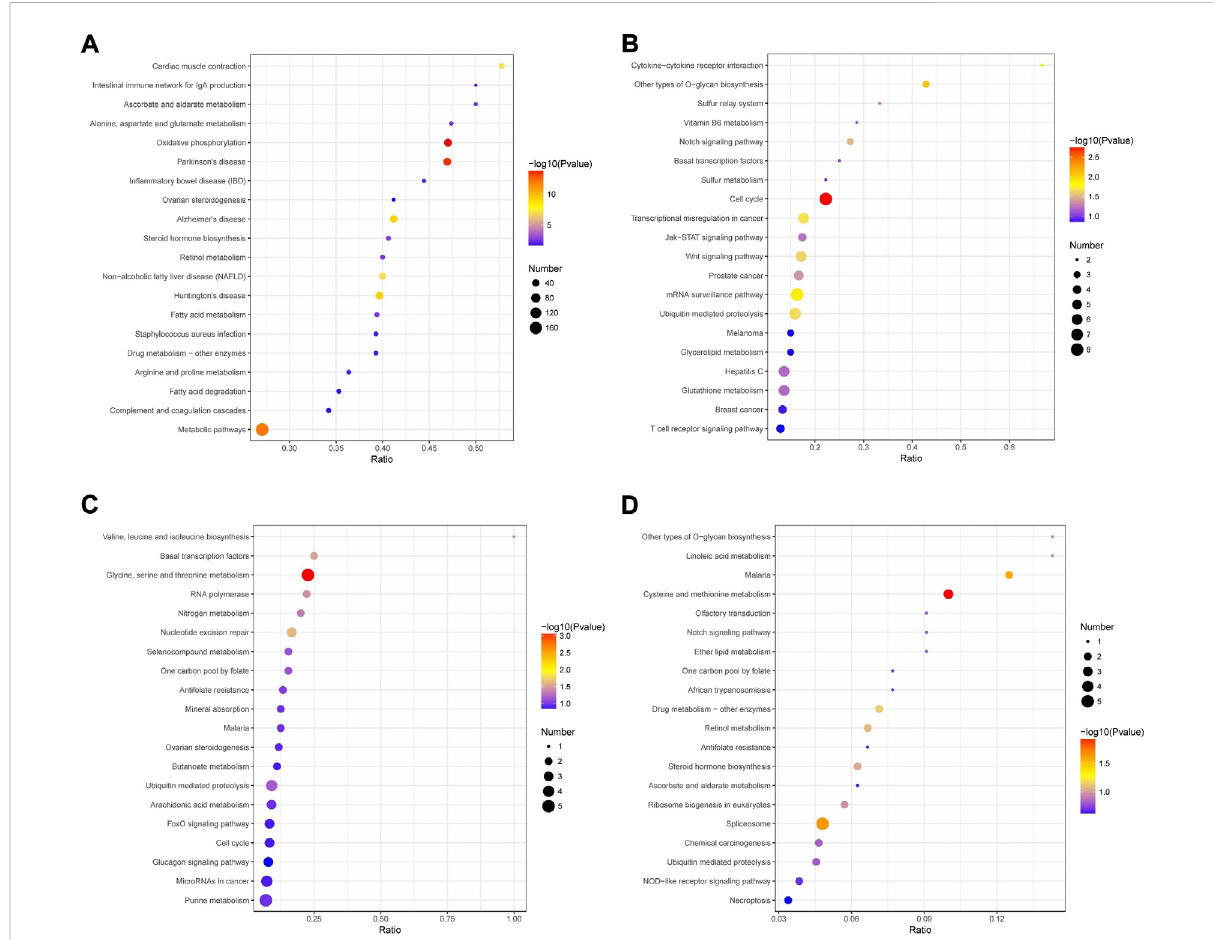
FIGURE 6 KEGGpathway enrichmentanalysis ofdifferentiallyabundantproteinsinrumenepitheliumbetween (A) day0andday15, (B) day15andday30, (C) day 30 and day 45 and (D) day 45 and day 60 of age. All pathways are listed according to p